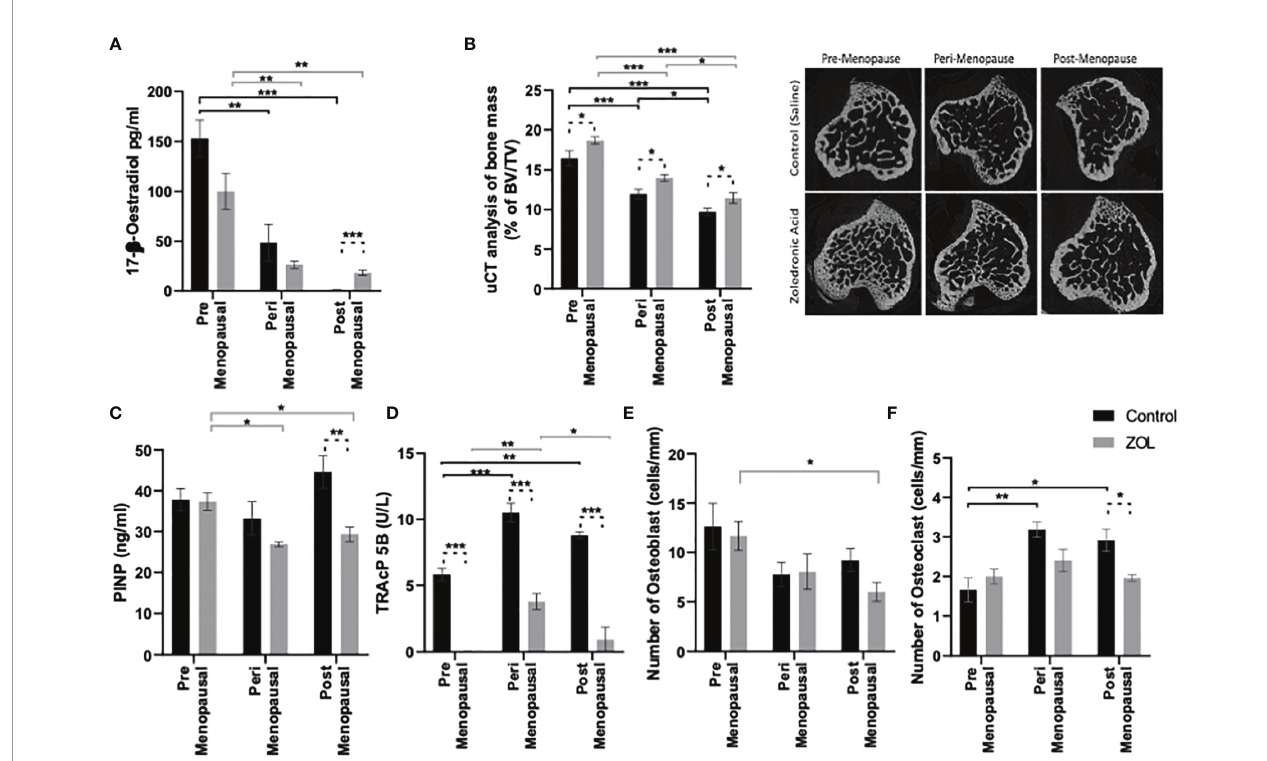
FIGURE 1 | Modelling pre-, post-, and peri-menopausal concentrations of oestrogen ± zoledronic acid in mice. Twelve-week-old immunocompetent BALB/c mice underwent ovariectomy, and 0, 1.38, or 12.5 mg/L oestradiol was immediately supplemented via their drinking water. Three days later, fi ve mice from each group received subcutaneous injection of 100 m g/kg zoledronic acid or saline control. All mice received a daily injection of 40 m g/kg goserelin. All data shown are 2 weeks following ovariectomy/oestradiol supplementation. (A) shows circulating concentrations of oestradiol in the plasma, as measured by ELISA. (B) shows the percentage of trabecular bone volume compared with tissue volume (TV/BV%) and radiomicrographs from representative m CT images. (C, D) shows effects on osteoblast and osteoclast activity, as measured by procollagen 1 intact N-terminal propeptide (P1NP) and tartrate-resistant acid phosphatase (TRAP) ELISA, respectively. (E, F) show effects on numbers of osteoclasts and osteoblasts that line trabecular and cortical bone per mm, respectively. All data on histograms are represented as mean ± SD; *p < 0.05, **p < 0.01, and ***p <